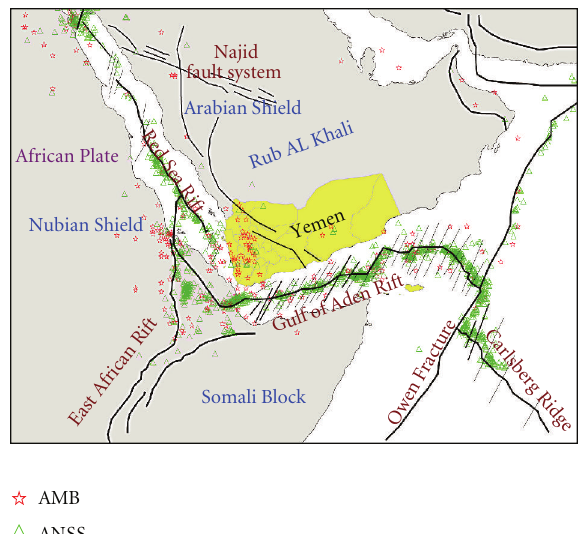
Figure 1: Earthquake catalogue events from two sources (AMB: Ambraseys et al. [7] and ANSS: Advanced National Seismic System Worldwide catalogue) plotted over the generalized seismotectonic feature